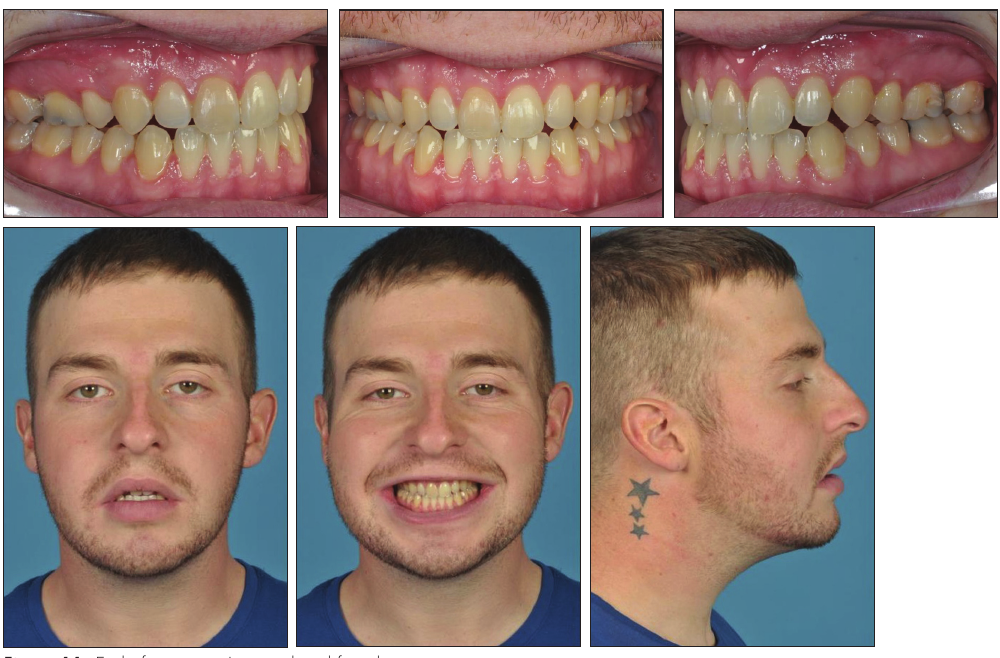
Figure 11. End of treatment Intra-oral and facial views.